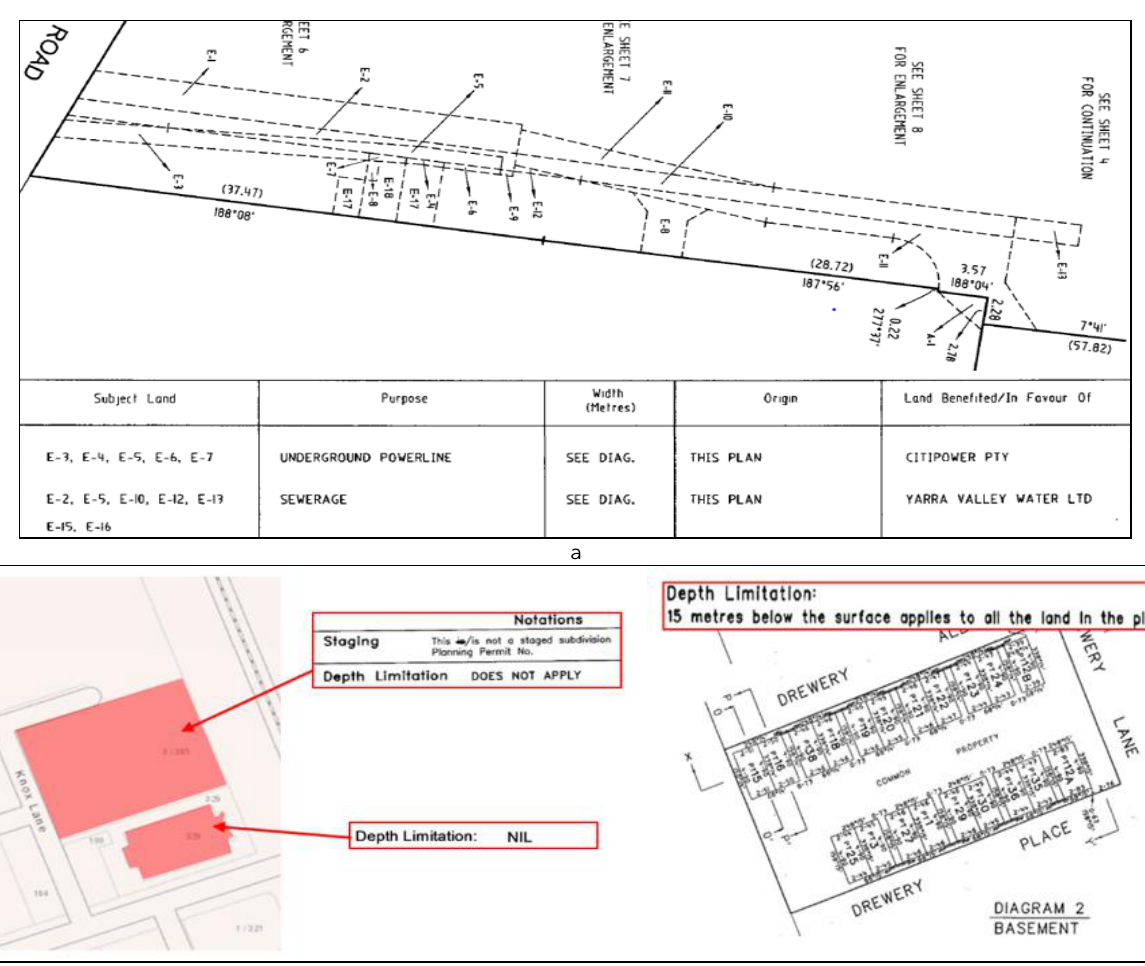
Figure 2 . Examples of underground secondary interests: a) easements; b) depth